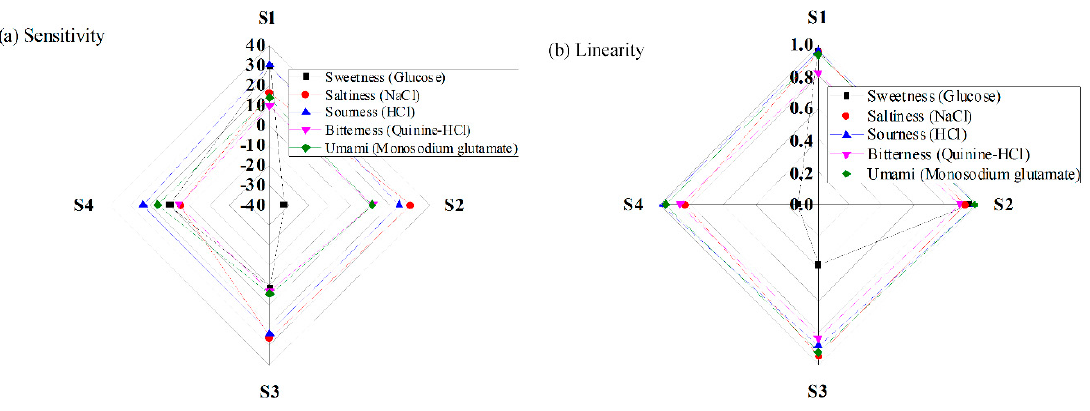
Figure 12. Performance of the designed IDC taste sensor array for various taste solutions: ( a ) sensitivity; and ( b ) linearity.